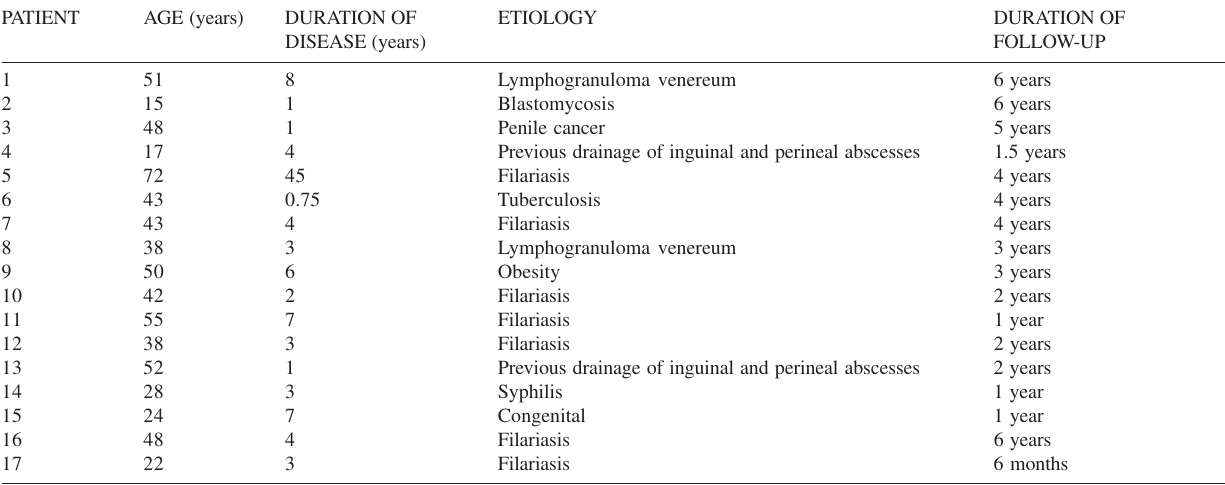
Table 1 - Clinical characteristics of the patients treated.